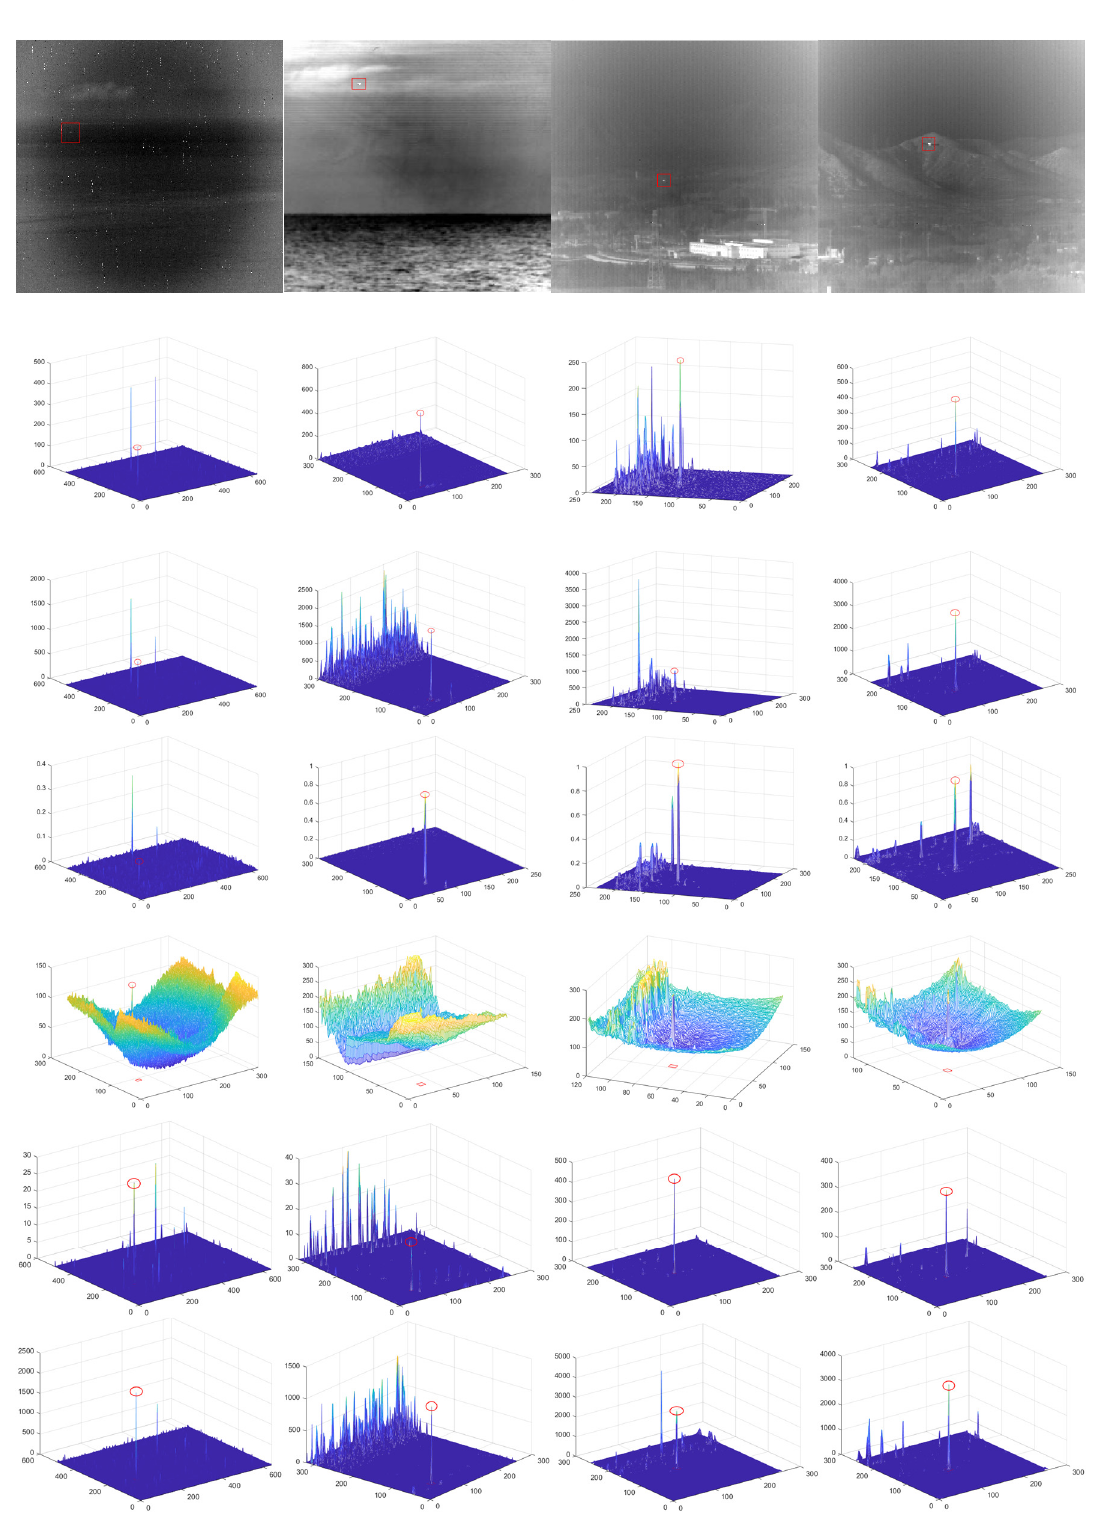
Figure 6. Comparison of detection results of different algorithms. From top to bottom: original images, results of proposed algorithm, results of MPCM, results of PQFT, results of ILCM, results of TLLCM and results of ADMD.